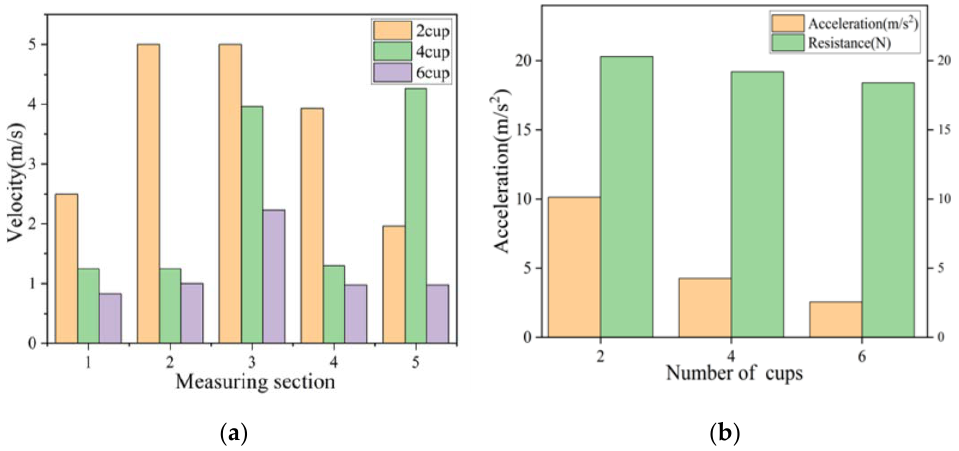
Figure 5. Velocity at each node, average acceleration, and resistance during cornering: ( a ) change of speed; ( b ) change of acceleration.